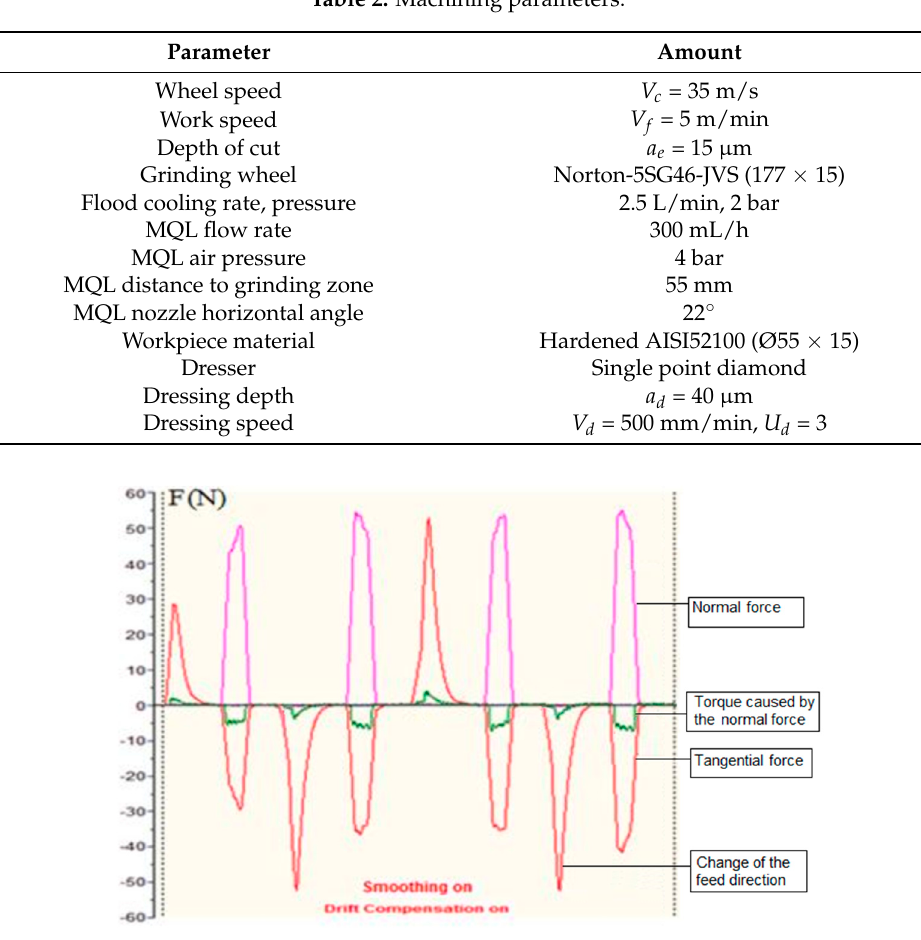
Figure 4. Grinding forces recorded by dynamometer.